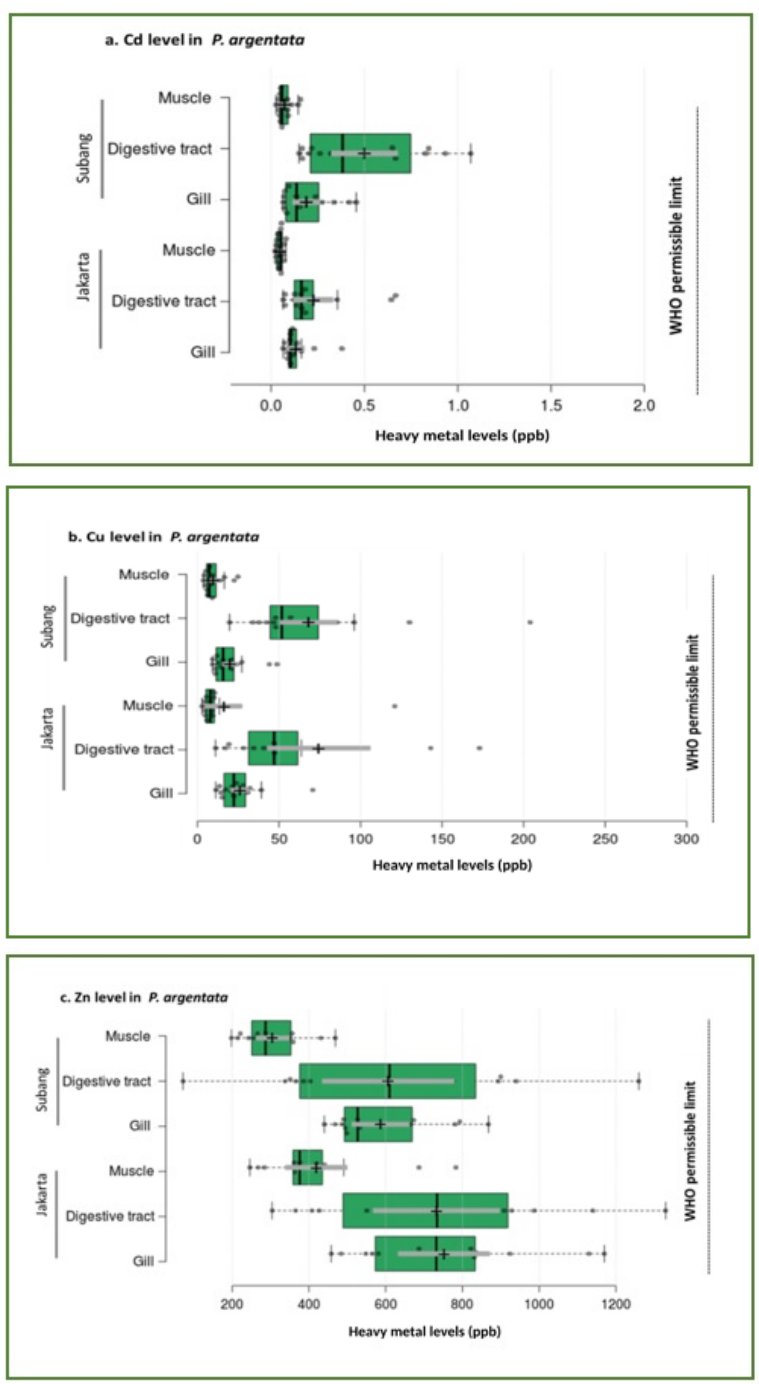
Fig. 4: Cd (a), Cu (b), and Zn (c) levels (ppb) in gills, digestive tracts, and muscle of P. argentata related to land use in Jakarta in the west (settlement dominance) and Subang in the east (mangrove dominance) in West Java coast, Indonesia with WHO permissible limit for Cd equals 3.0 ppb, for Cu equals 1000.0 ppb, and 100,000 ppb for Zn (Abdel-Baki et al., 2011)